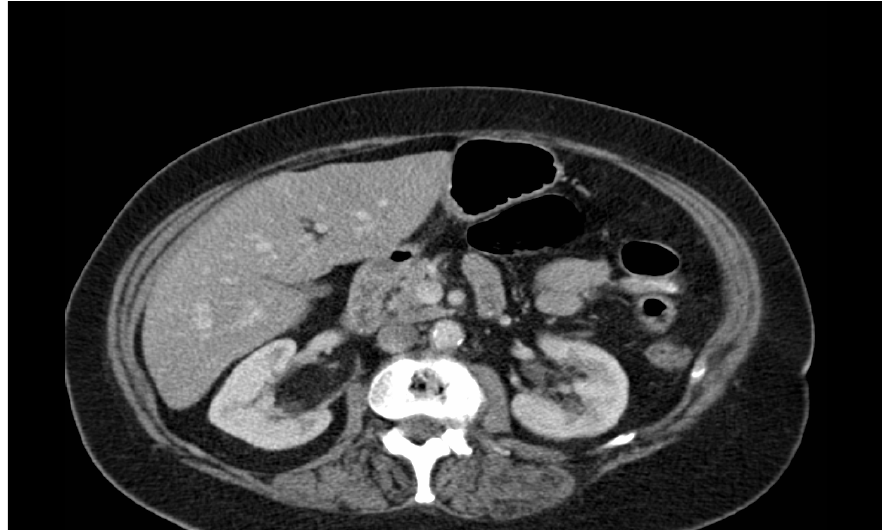
FIGURE 1 . CT of the abdomen, demonstrating a right-sided tumour invading the renal vein.